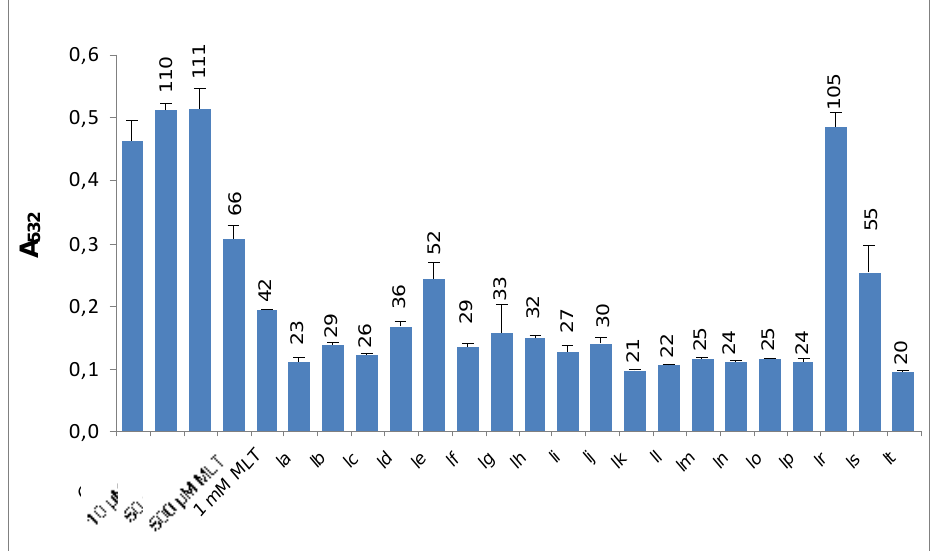
Figure 3. Effects of various concentrations of MLT and 10 μ M synthesised indole derivatives on H O -induced lipid peroxidation in erythrocyte membranes. MDA values 2 2 were determined as an endproduct of lipid peroxidation. Values are mean ±SD of three individual experiments. Values above the bars are % control